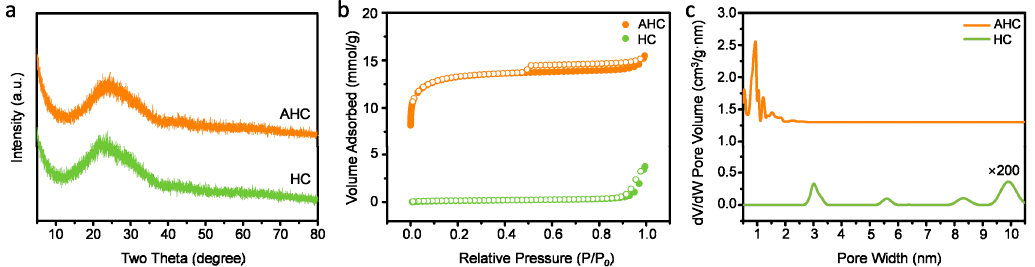
Figure 2. ( a ) XRD spectra of activated (AHC) and non-activated (HC) hydrochar. ( b ) N 2 adsorption- desorption isotherms and ( c ) pore size distributions for AHC and HC.